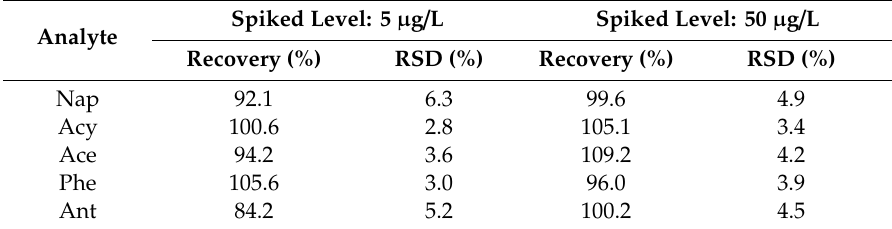
Table 2. The recovery and precision of the extraction performance for PAH compounds in spiked river water samples.